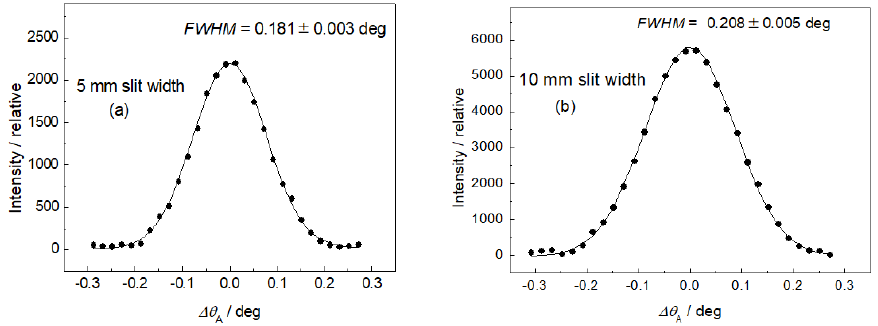
Figure 7. Rocking curves for the slightly deformed α -Fe(110) low-carbon steel rod of ϕ = 4.9 mm installed in horizontal position for ( a ) 5 mm slit width and ( b ) 10 mm slit width .